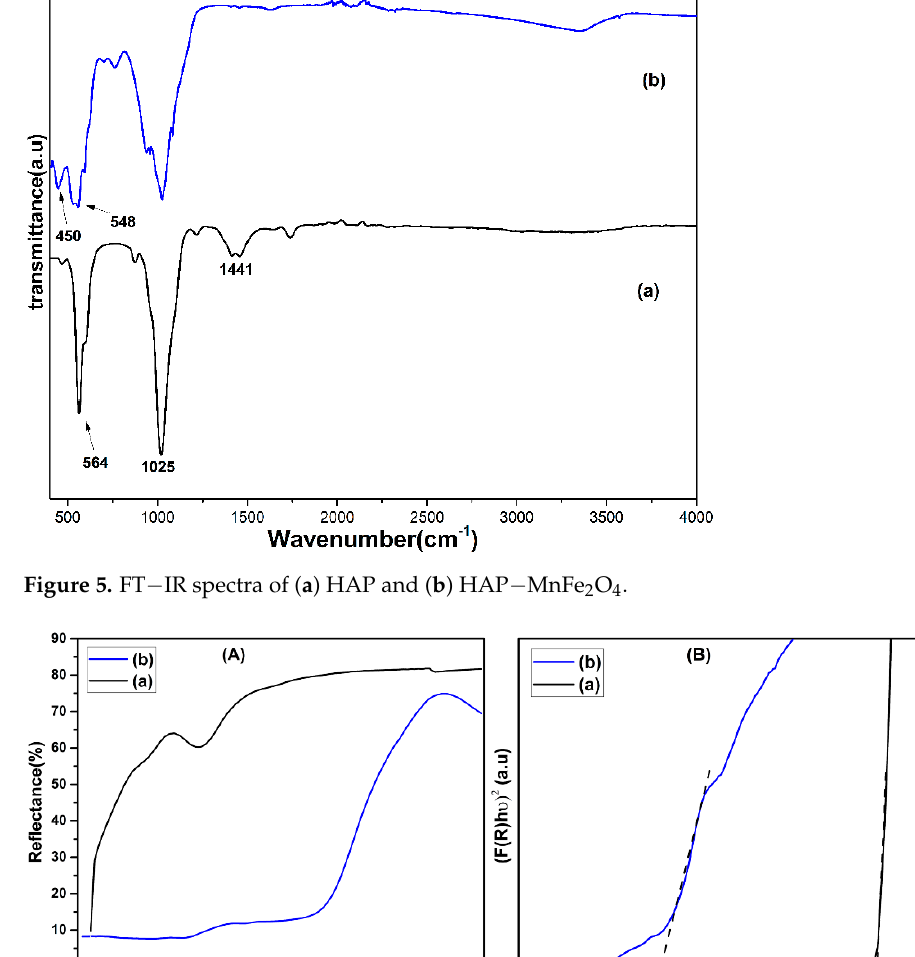
Figure 6. ( A ) UV–Vis diffuse reflection spectra and ( B ) plot of the transformed Kubelka–Munk function versus the gap energy of sample ( a ) HAP and ( b ) HAP − MnFe 2 O 4